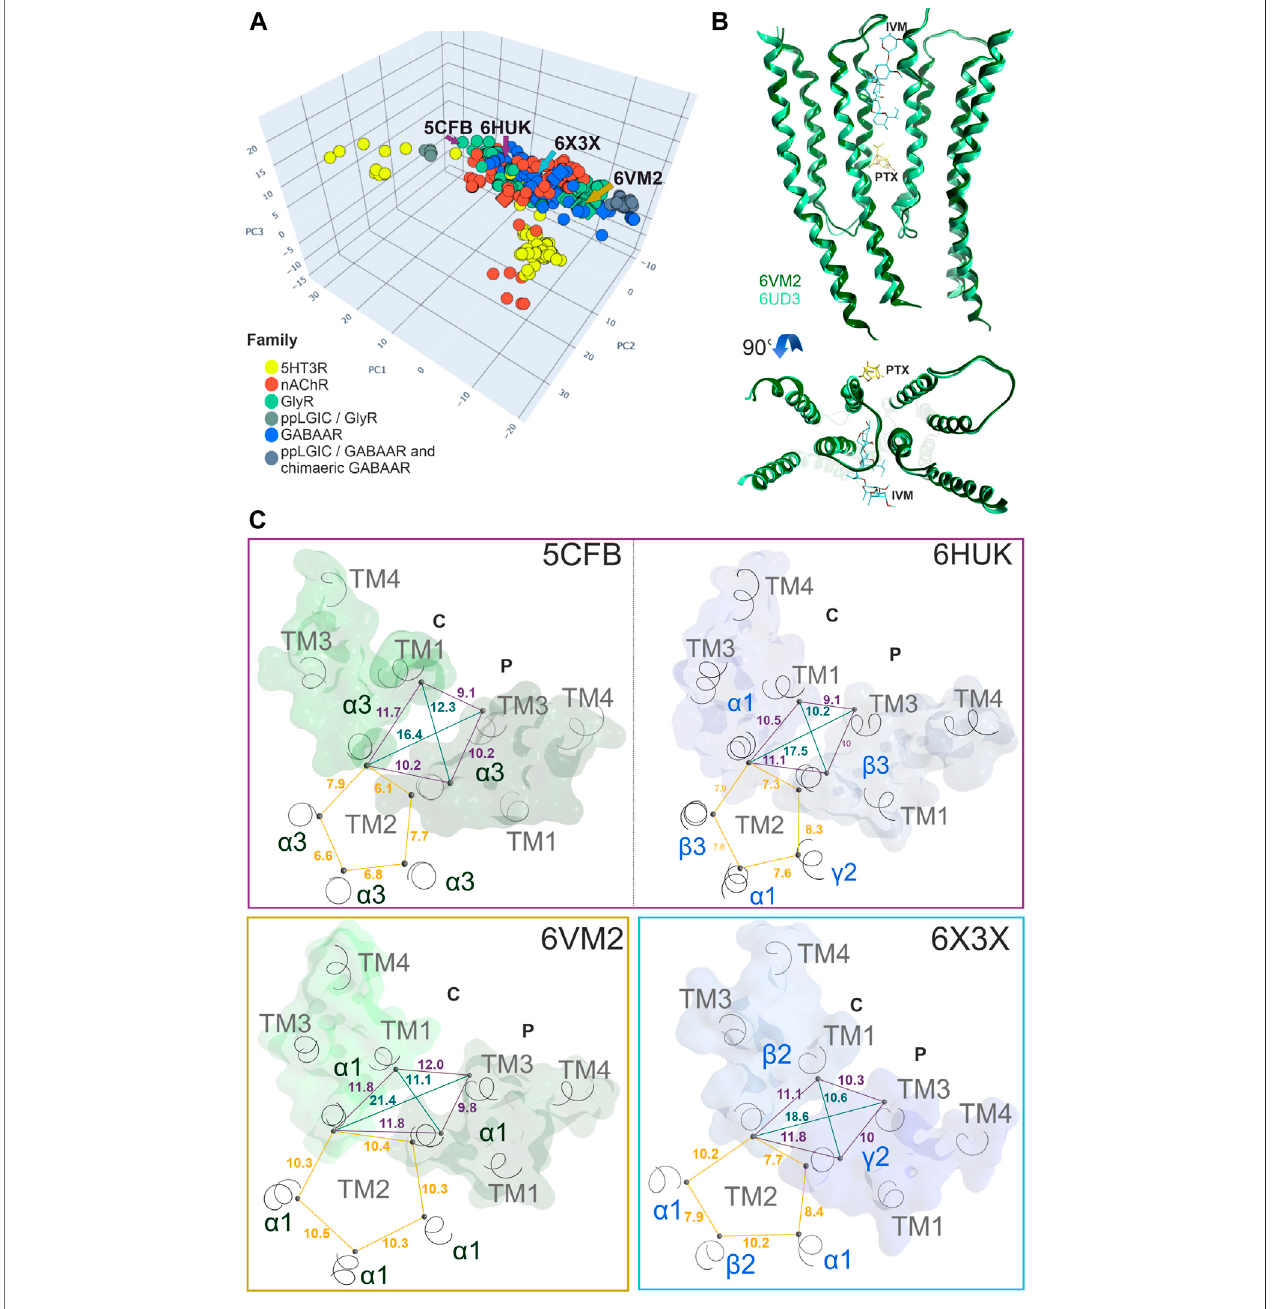
FIGURE5| ConformationanalysisoftheupperTMDinterfacepocket: (A) Scatterplotofthepocketconformations.Eachdotrepresentstheresultsforanindividual upper TMD interface, diamond shaped symbolsindicate thepresence ofa ligand inthe analysed site. The colour ofthe dots indicates the protein familyasde fi ned in the legend,grayisusedfordiversechimeras.ppLGIC:procaryoticpentamericligandgatedionchannel.ArrowsandPDBIDsindicatethelocalizationofstructureswhichare rendered in panels (B) and (C) , arrow and box colours match across the panels. (B) Superposition and comparison of two interface forming subunits of the ivermectin bound Gly R structure 6VM2 and the picrotoxin bound 6UD3, featuring nearly identical conformations of the entire TMD. (C) Different conformations result in different distances between alpha carbon atoms: A plane through the upper TMD is depicted with all fi ve TM2 segments and two subunits. Distances between alpha carbons are shown to illustrate backbone conformation, where yellow lines are distances between homologous pore forming TM2 residues as an indication for asymmetry, purple lines are distances between pocket forming residues de fi ning the circumference, and green lines the pocket “ diagonals ” .